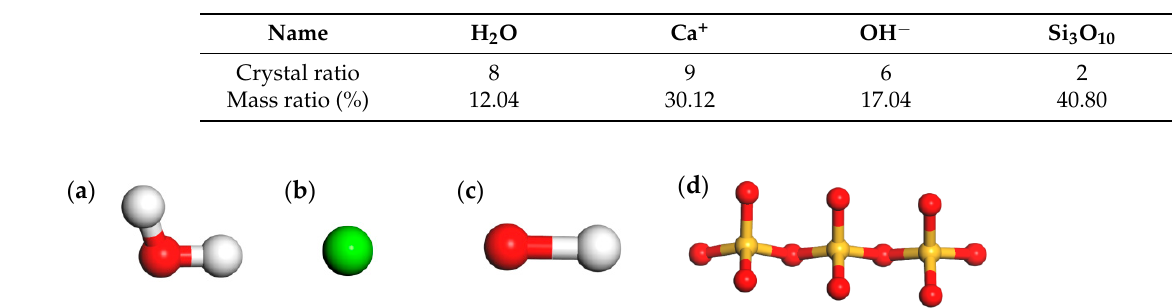
Figure 6. The molecular model of C-S-H gel components. ( a ) H 2 O molecular model; ( b ) Ca + ion model; ( c ) OH − ion model; ( d ) Si 3 O 10 molecular model. Table 2. Proportions of C-S-H gel composition.